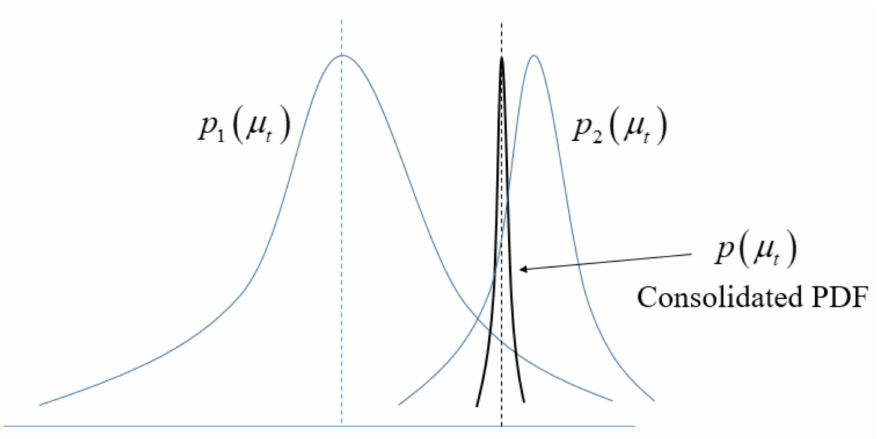
Figure A3. Bayesian Consolidation of Two Prior